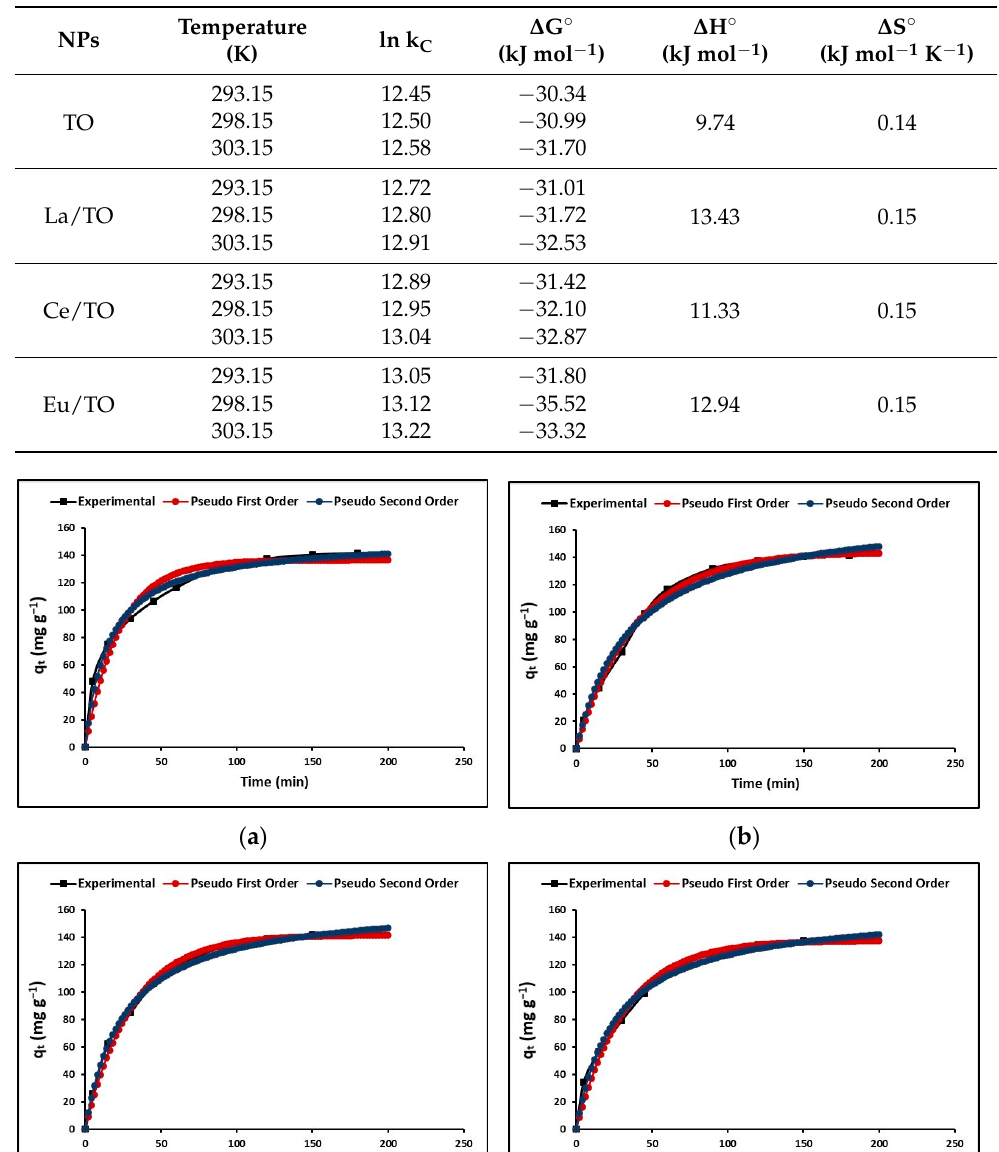
Table 3. Thermodynamic parameters of cyanide adsorption onto nanoparticles.